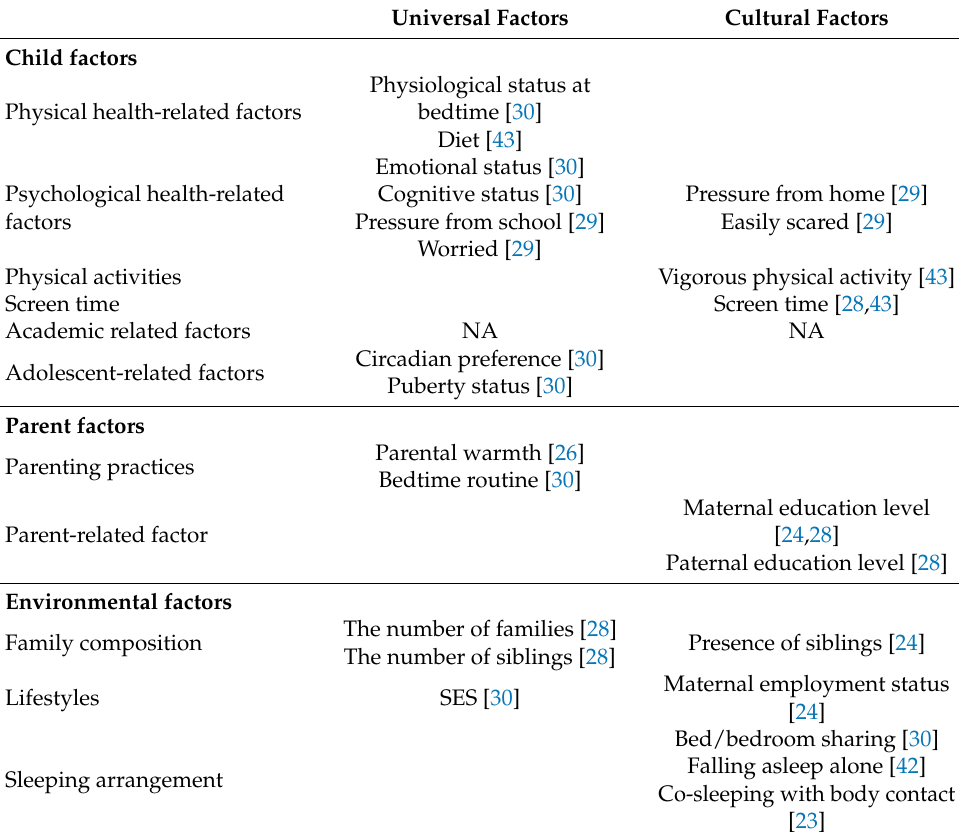
Table 4. Universal or cultural factors associated with sleep duration or disturbances in young popu-